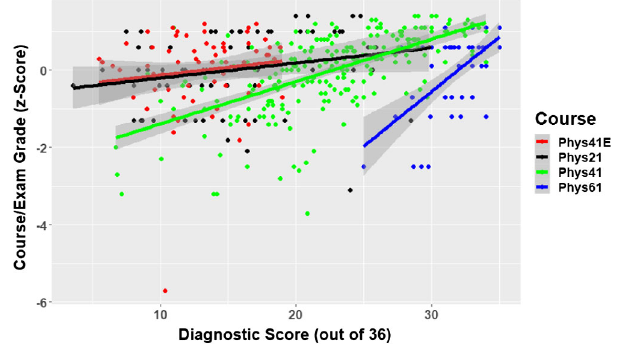
FIG. 2. Student course grades (Phys 61 and Phys 21) or exam grades (Phys 41 and Phys 41E) as a function of diagnostic exam scores. Points in red are for Phys 41E (the calculus-based course for students with no prior physics), points in black are for Phys 21 (the algebra-based mechanics course), points in green are for Phys 41 (the calculus based course for scientists and engineers), and points in blue are for Phys 61 (the honors course for physics majors). We include ordinary least squares trend lines and associated standard errors to guide the reader ’ s